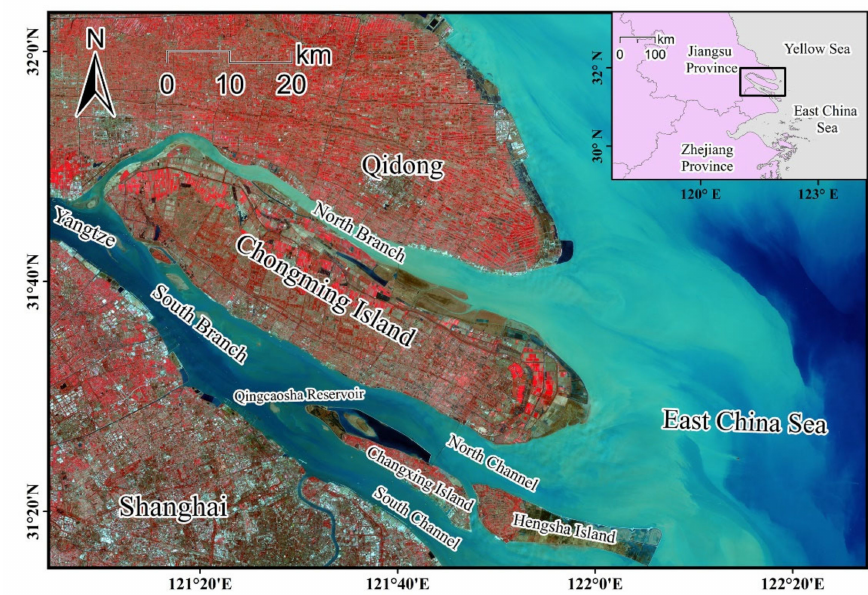
Figure 1. Study area: Chongming Island, Shanghai, China. The background picture is a Landsat OLI image obtained on 9 March 2020, with standard false color composition (near-infrared band in red, red band in green, and green band in